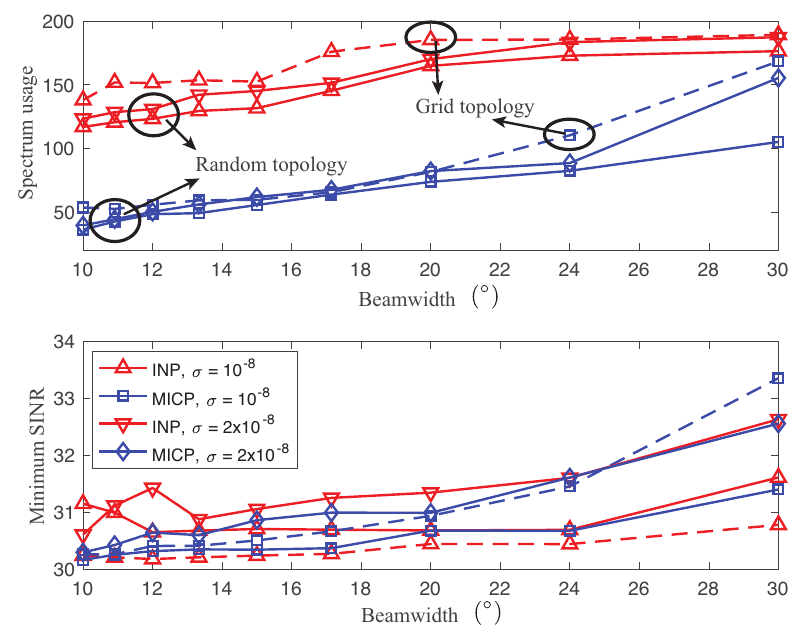
Figure 7. Expected values of the spectrum usage ( top ) and minimum SINR ( bottom ) using the solutions of both the INP and MICP as functions of different beamwidths θ = 10 ◦ , . . . , 30 ◦ with σ = 10 − 8 ,2 × 10 − 8 . The solid line and dotted line show the performance with the random and grid topologies,